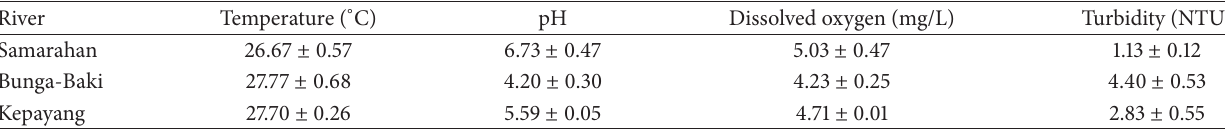
Table 3: Selected water quality parameters measured in situ .